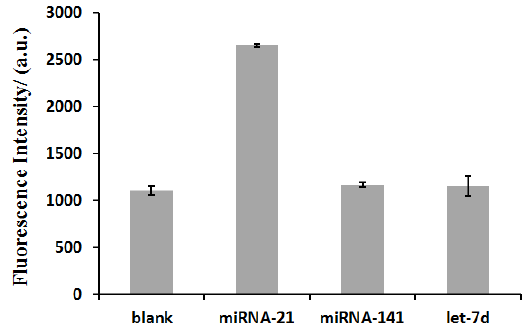
Figure 5. The proposed method is highly selective for target miRNA detection. Respectively 800 nM of miRNA-141 and let-7d were used in the presence of 200 nM HP and 20 U/mL exo I. The concentration of miRNA-21 was 200 nM. “Blank” is the sample without miRNA. Error bars were estimated from three replicate measurements.